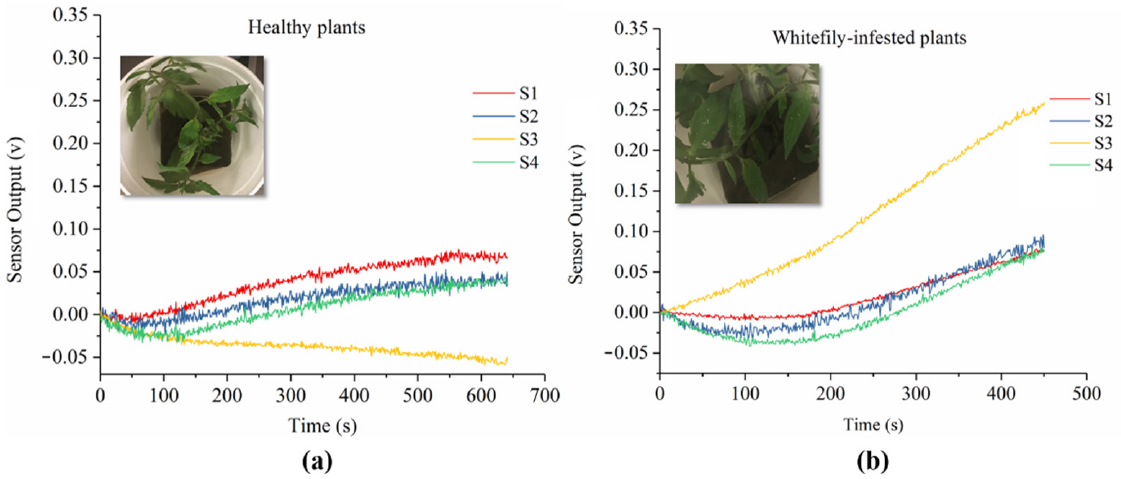
Figure 4. Sensor performance of E-nose system towards healthy ( a ) and whitefly-infested ( b ) tomato plants.